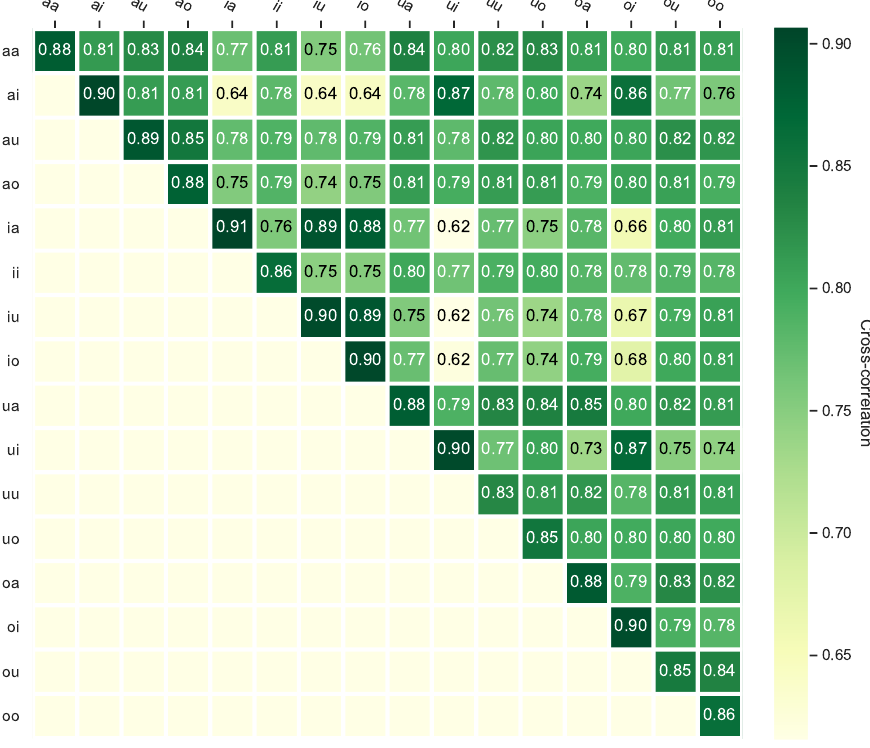
Figure A4. CC awe calculated between samples from reference dataset. Higher values correspond to acoustically more similar